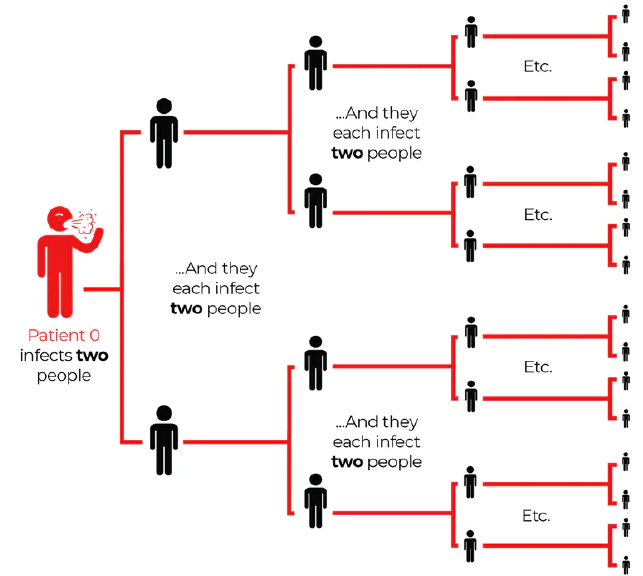
Figure 1. COVID-19 spreading